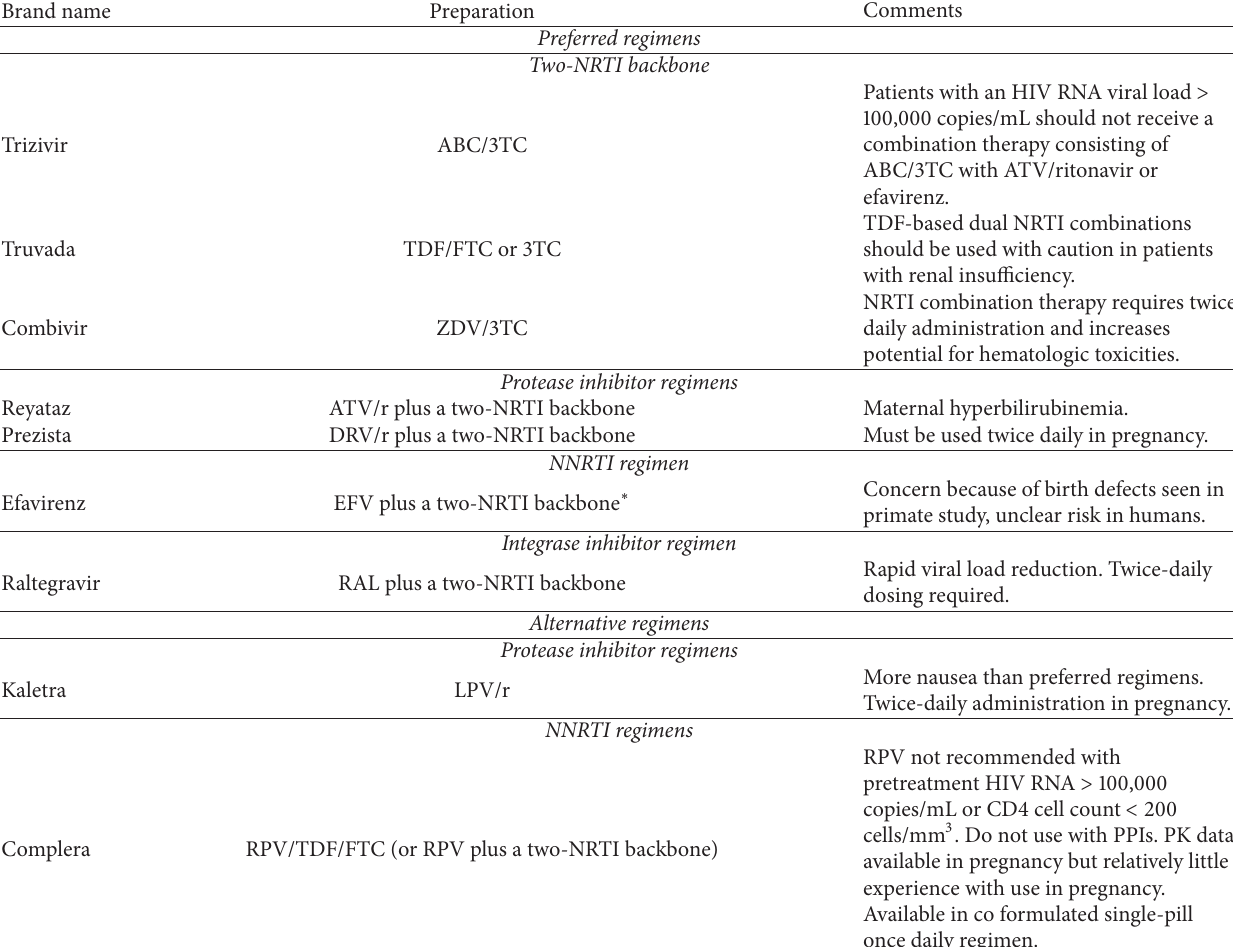
Table 2: Treatment regimens for HIV-infected pregnant